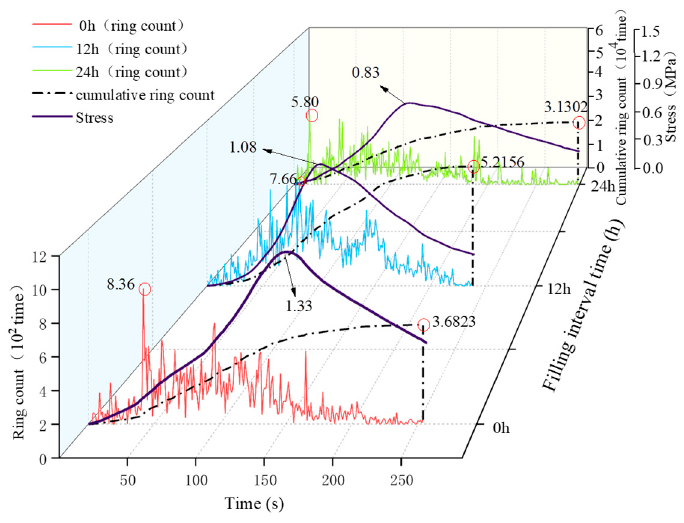
Figure 6. Ringing count of LCTB with different filling interval time.